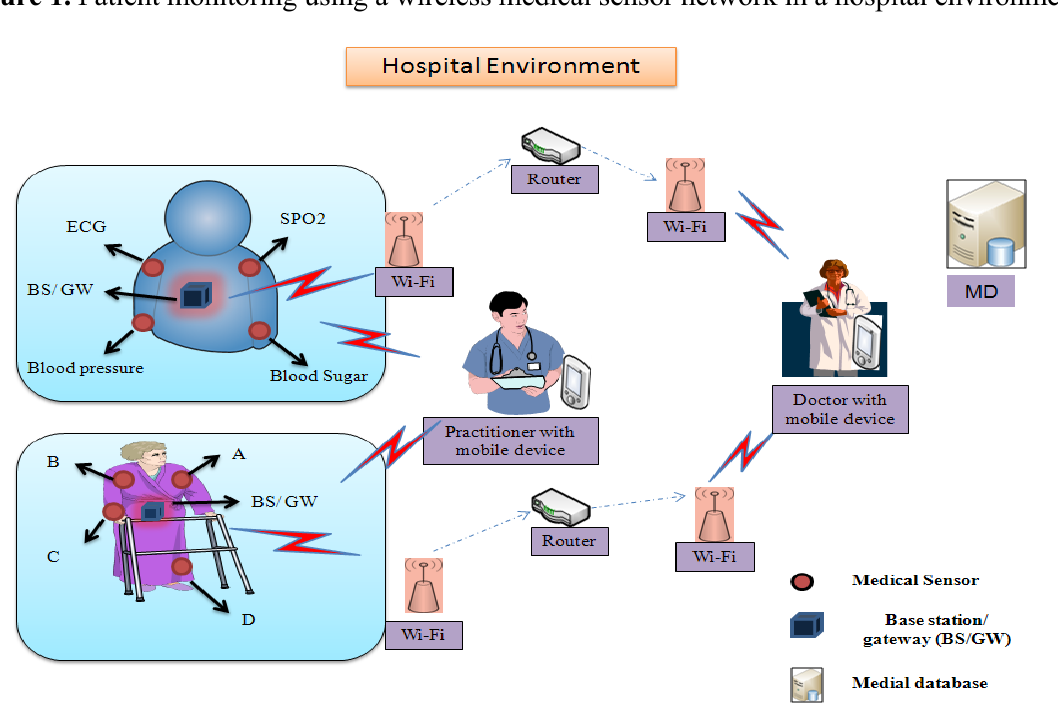
Figure 1. Patient monitoring using a wireless medical sensor network in a hospital